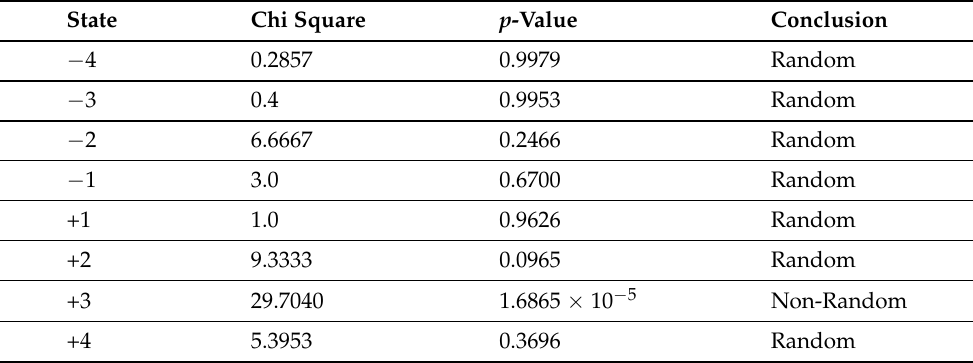
Table 5. NIST random excursion test for sequence ( w 2 n ) n ≥ 0 given by